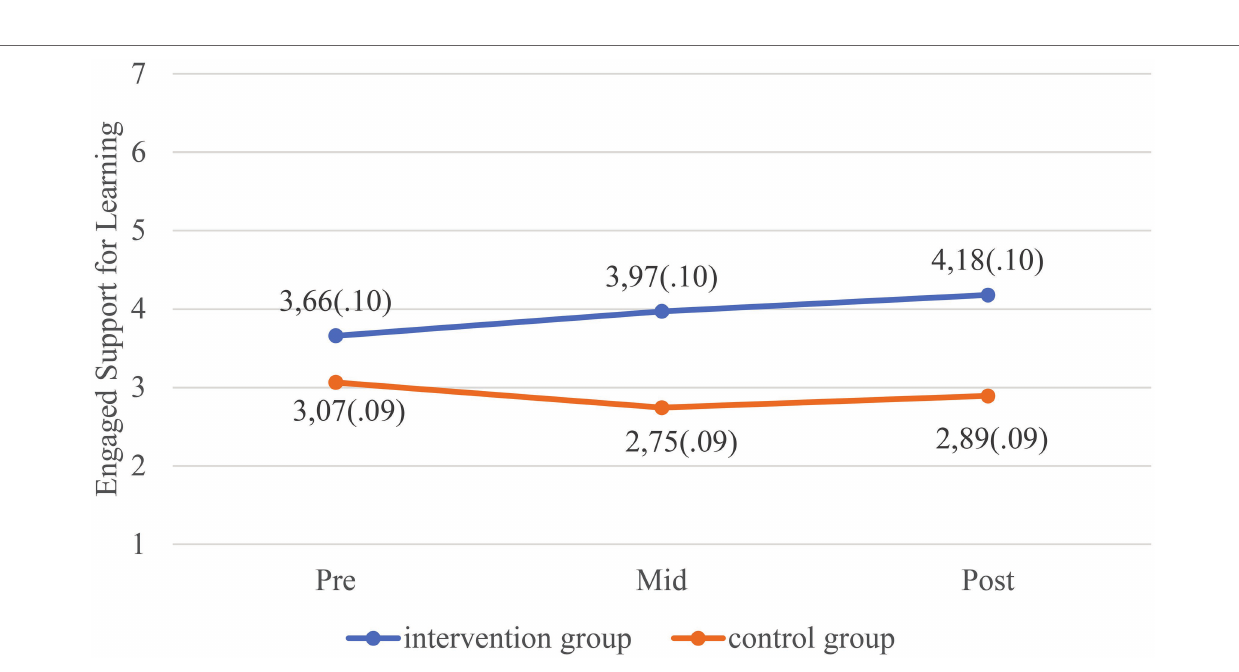
FIGURE 3 | Estimated marginal means with standard error (SE) for Engaged Support for Learning (ESL) at three timepoints separated by groups. Higher scores indicate better